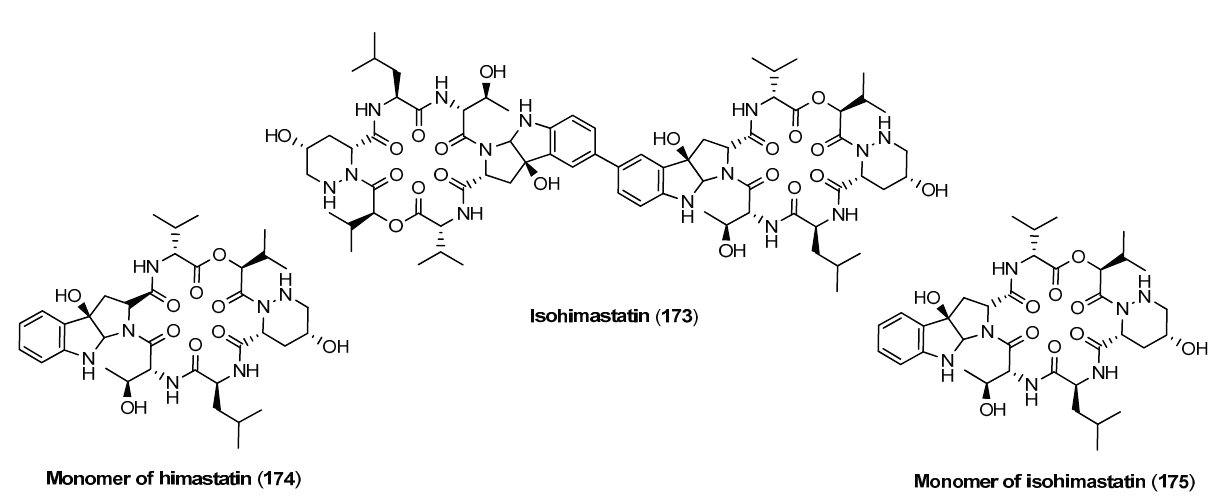
Figure 17. Analogues of